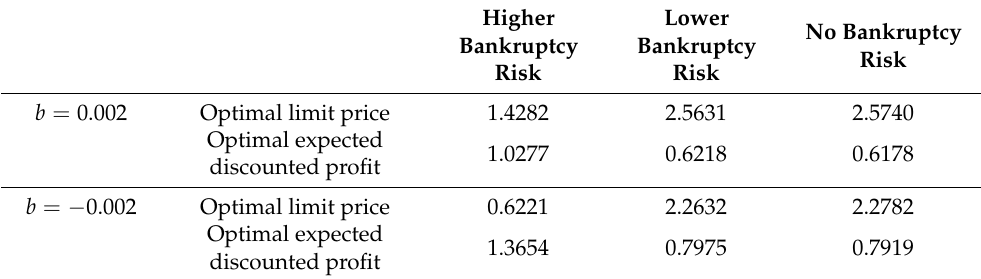
Table 2. The optimal limit prices and their optimal expected discounted profits of the buy